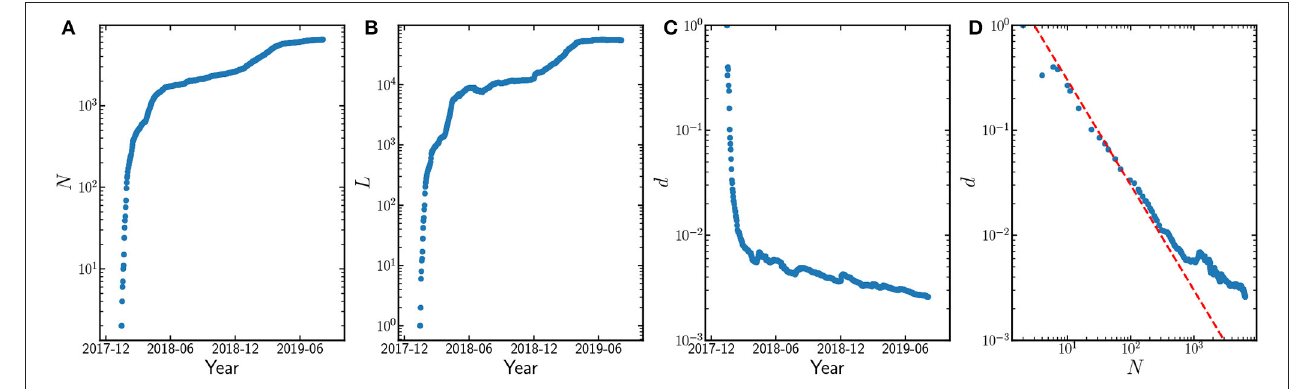
FIGURE 5 | Evolution of the total number of nodes N (A) , total number of links L (B) and link density d = 2 L As for the BAN and the BUN, the position d ∼ N − 1 well describes the link density dependence on N (D) , at least for the snapshots for which N ≤ 10 3 . See also Lin et al.